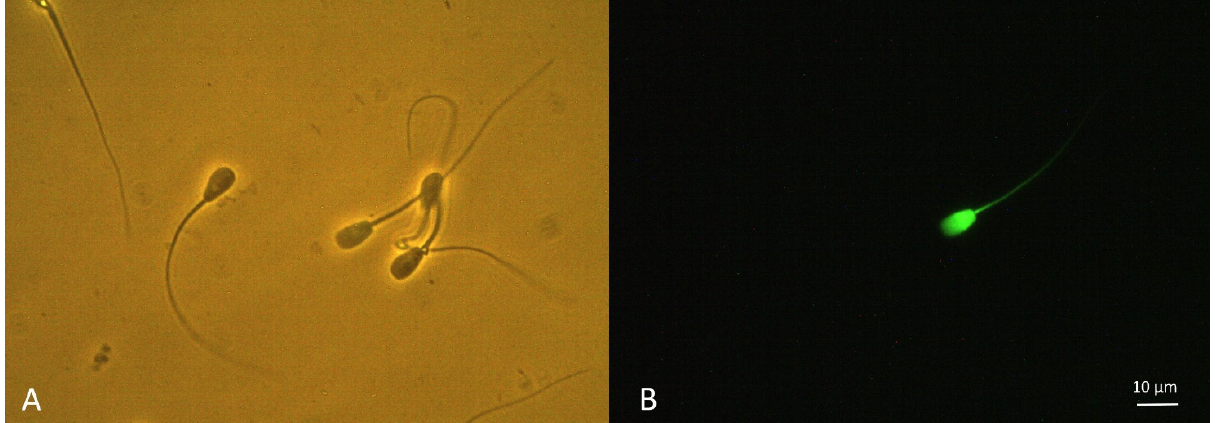
Figure 4. Immunolocalization of Kiss1R on canine spermatozoa recovered from the epididymal head and stained with the rabbit polyclonal antibody against amino acids 141–342 mapping within an internal region of Kiss1R labelled by a Zip Alexa Fluor 488 Rapid Antibody Labelling Kit. On the left ( A ), the field (400× magnification) was acquired using phase contrast microscopy and showed the presence of several spermatozoa. On the right ( B ), the same field was acquired using epifluorescence microscopy (long pass filter; 470–490 excitation, >510 nm emission). Among the spermatozoa present in the field, only one spermatozoon showed a bright green fluorescence, indicating the presence of Kiss1R on sperm surface (bar = 10 µm).